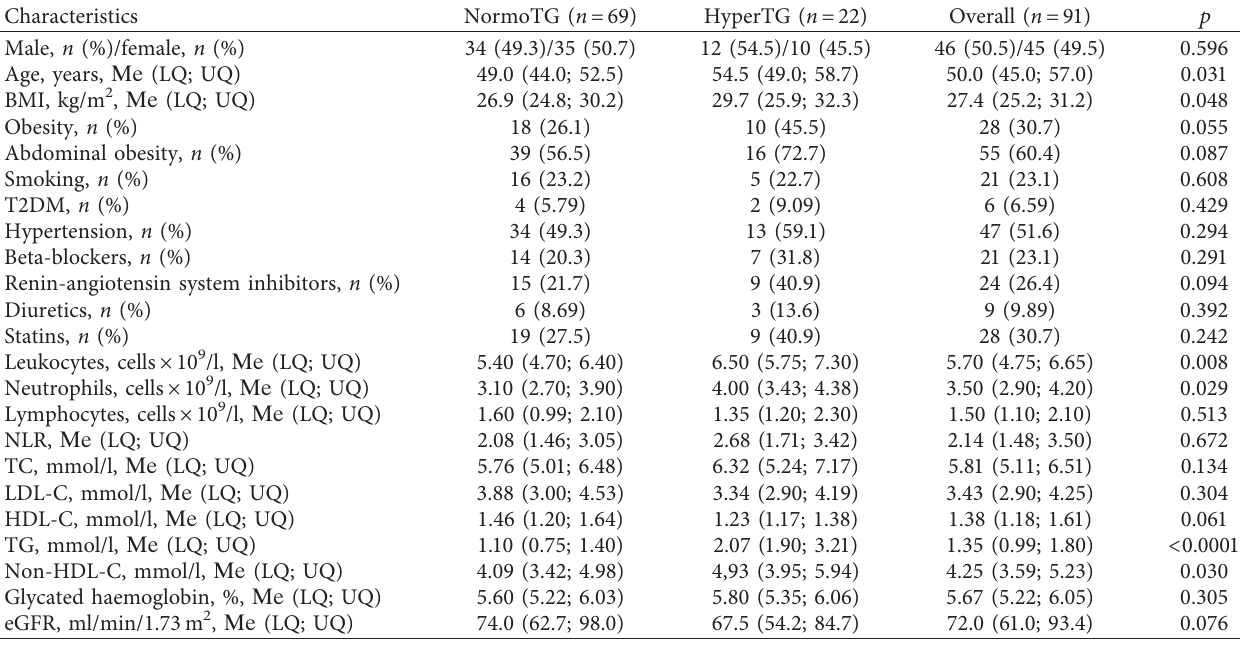
Table 1: Clinical and laboratory characteristics of patients.